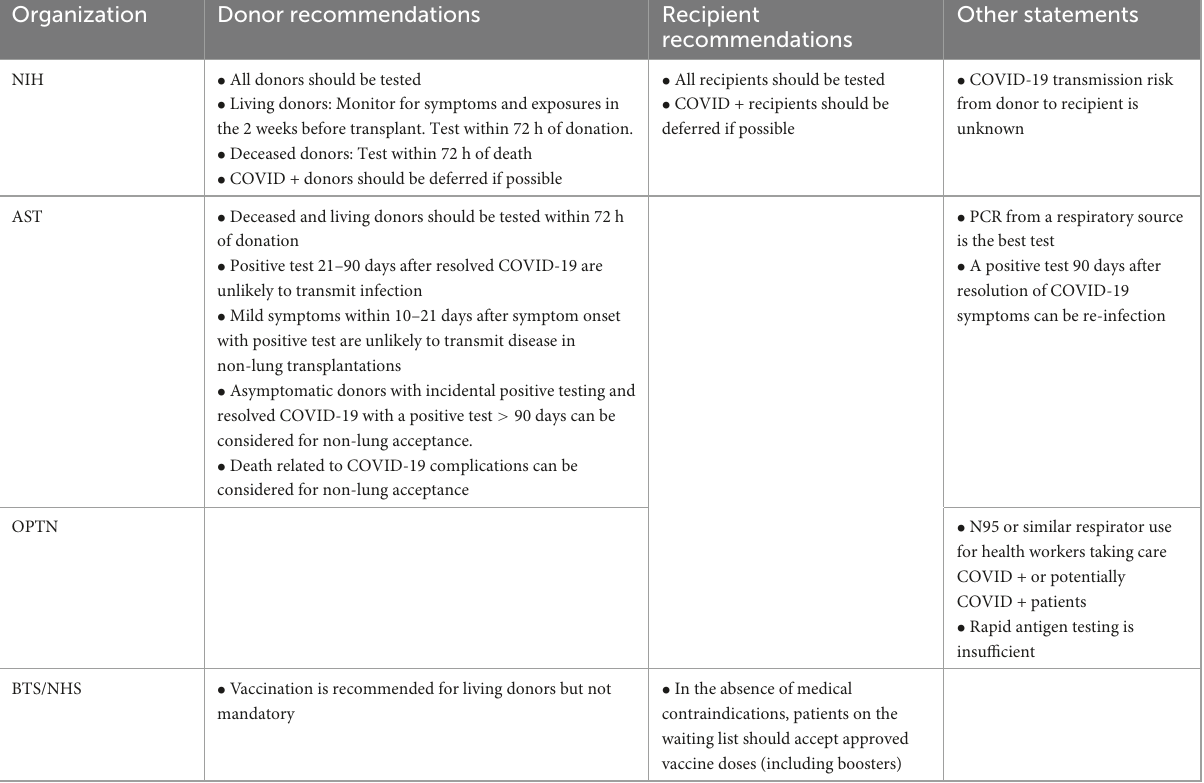
TABLE 1 National organization recommendations for COVID-19